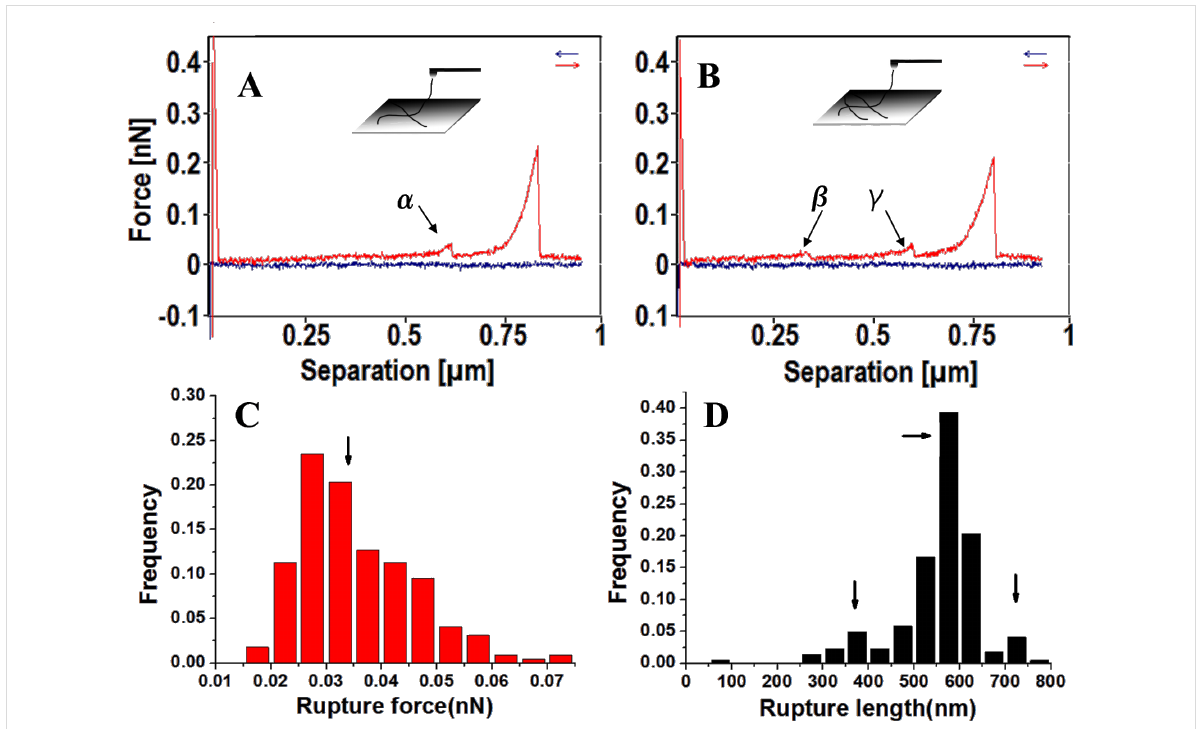
Figure 5: A,B) Typical single stretching event with one and two kinks (type 2), the insets are the proposed models. C,D) The frequency distributions of rupture force and rupture length of kinks in force curves with only one kink, respectively.